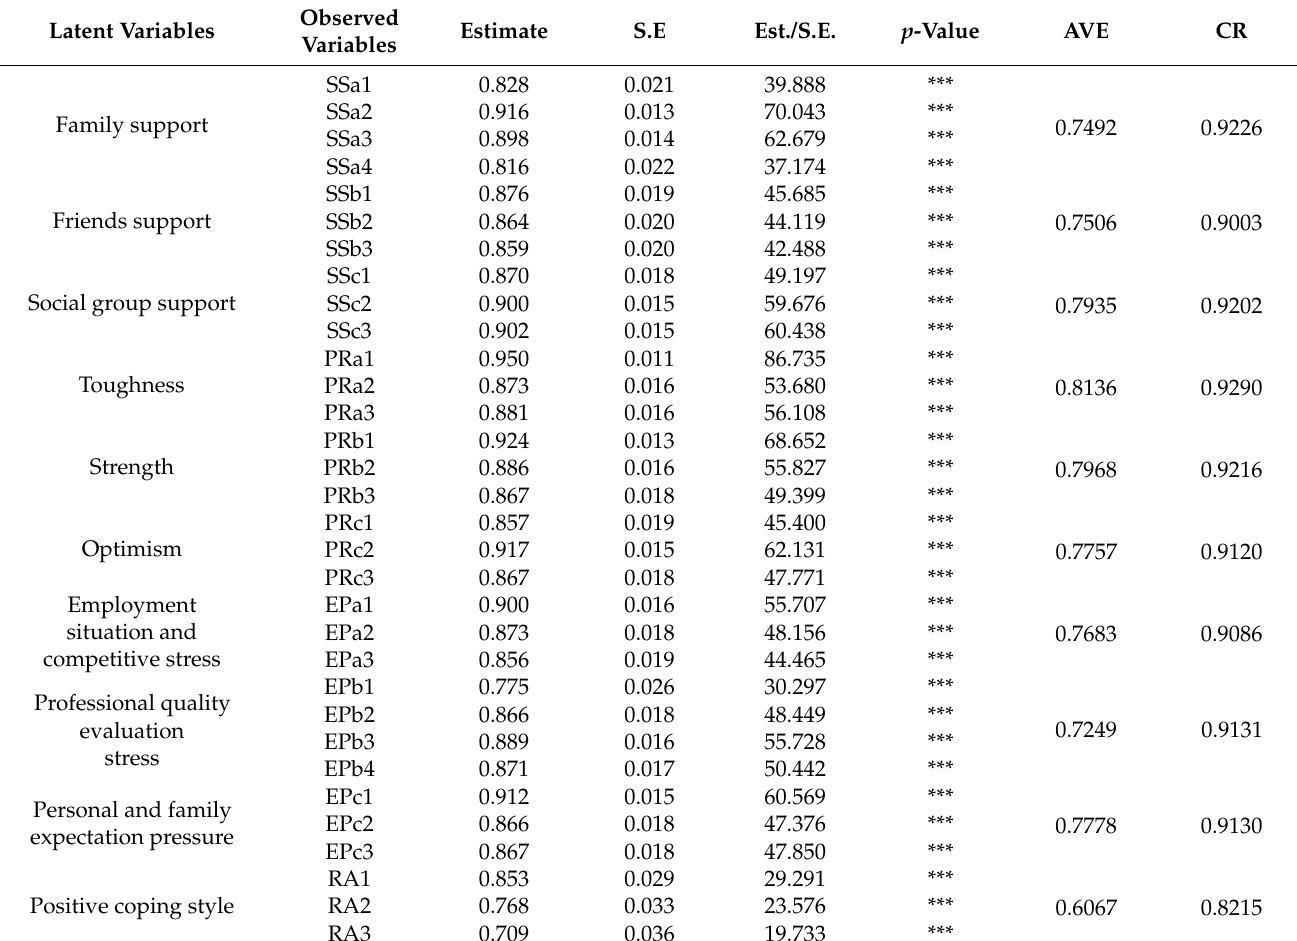
Table 2. Confirmatory factor analysis parameter